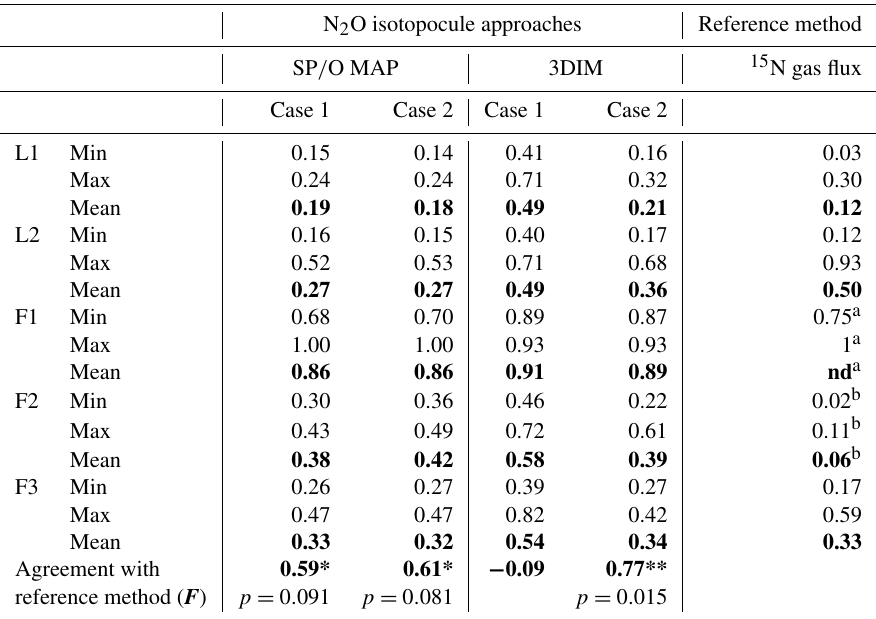
Table 3. Comparison of N 2 O residual fraction ( r N ) determined with the N 2 O isotopocule approaches (SP / O MAP and 3DIM) and the 2 O reference method ( 15 N gas flux). Minimal (min), maximal (max), and mean values were calculated with the each sampling mean values (of all replicates). The agreement with the reference method was assessed with the Nash–Sutcliffe efficiency ( F , Eq. 19) (Nash and Sutcliffe, 1970), which represents the R 2 of the fit to the 1 : 1 line (Fig.